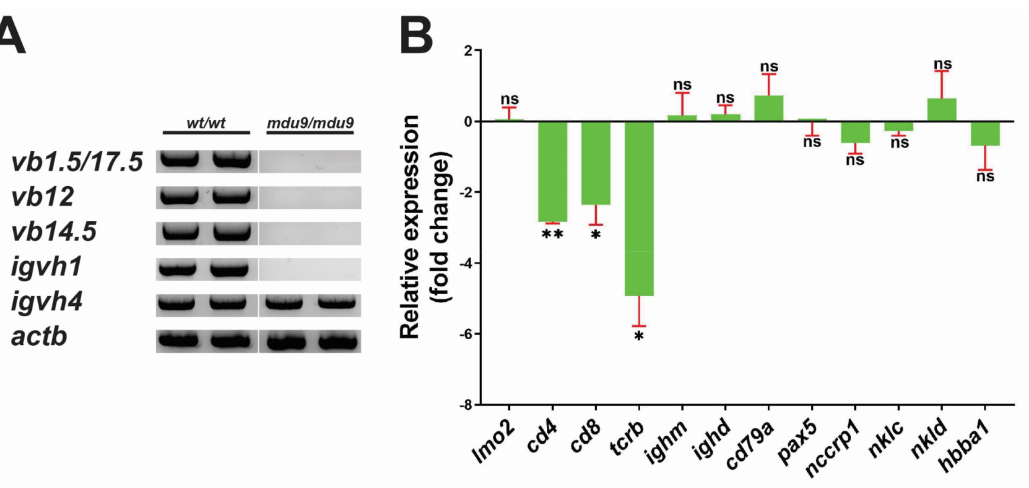
Figure 3. Effect of SCID-derived JAK3 mutations on zebrafish larval lymphopoiesis. Analysis of immune and blood cells in 28 dpf wild-type ( wt / wt ) and mutant ( mdu9 / mdu9 ) jak3 larvae using RT-PCR with primers specific for T cell receptor (TCR) β -chain ( v(d)j-c β vb1.5 , vb12 , vb14.5 ) and B cell Ig heavy chain ( igvh1, igvh4 ) rearrangements along with actb as a control ( n = 2) ( A ), noting that RT-negative controls yielded no products, or qRT 2 -PCR analysis with the indicated hematopoietic cell markers ( B ). Data is represented as relative fold-change compared to homozygous wild-type ( wt / wt ) larvae with mean and SEM shown in red and level of statistical significance of